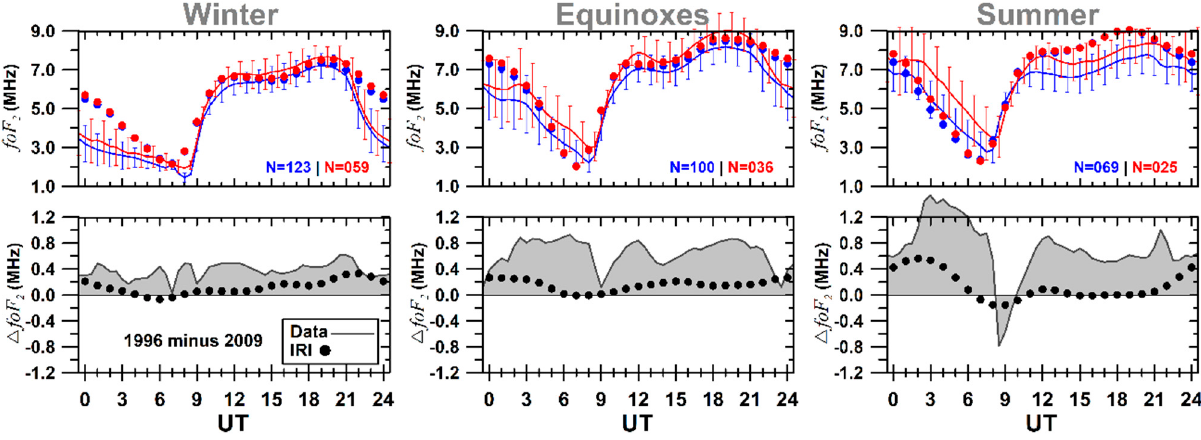
Figure 4. Similar to Figure 3, but for foF 2 .